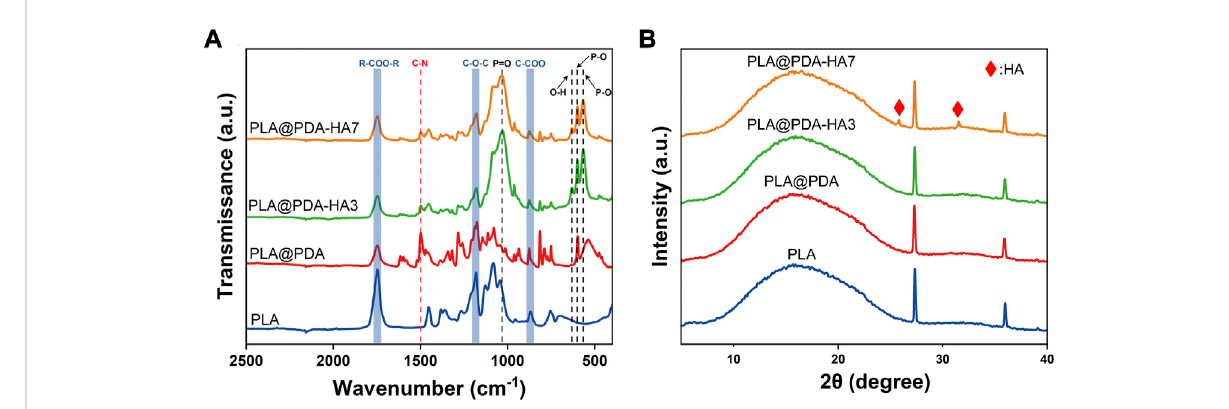
FIGURE 3 FTIR-ATR spectrum (A) and XRD pattern (B) of PLA, PLA@PDA, PLA@PDA-HA3, and PLA@PDA-HA7